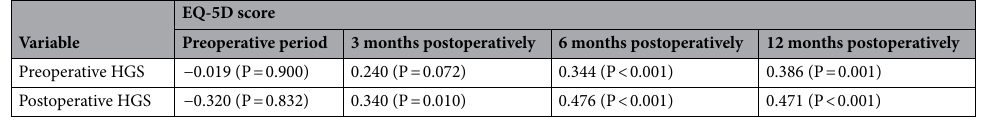
Table 3. Spearman rank correlation coefficient between HGS and EQ-5D score. EQ-5D European Quality of Life Five Dimension, HGS handgrip